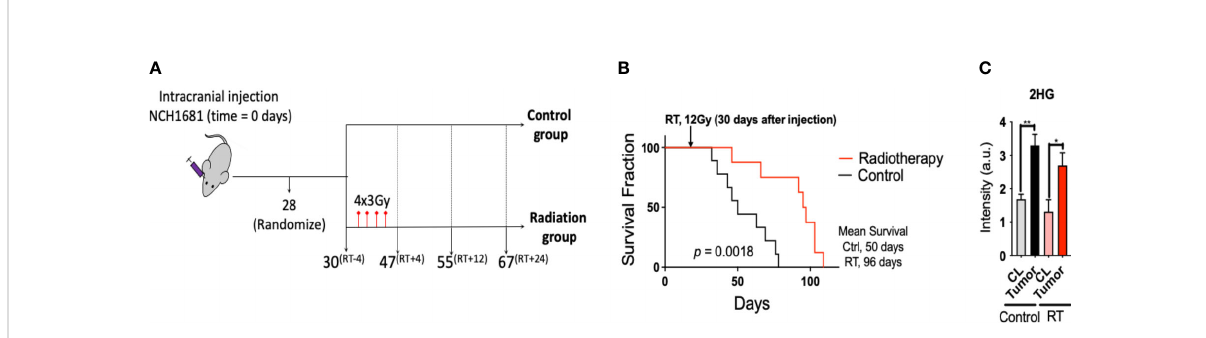
FIGURE 1 Radiotherapy for a mouse model of IDH1 mutant astrocytoma: (A) , Diagram of the experimental set up of the investigation (superscripts indicating the time in days relative to radiotherapy). (B) , Survival curves for the glioma mouse model under radiation and control (RT, radiotherapy) (n=9). (C) , 2HG levels obtained by LC/MS analysis in the tissues indicated (n=4 samples/group). Statistical signi fi cance from a two way-ANOVA followed by Sidak ’ s multiple comparison test displayed as **, p<0.005; *, p<0.05 (only signi fi cant differences are